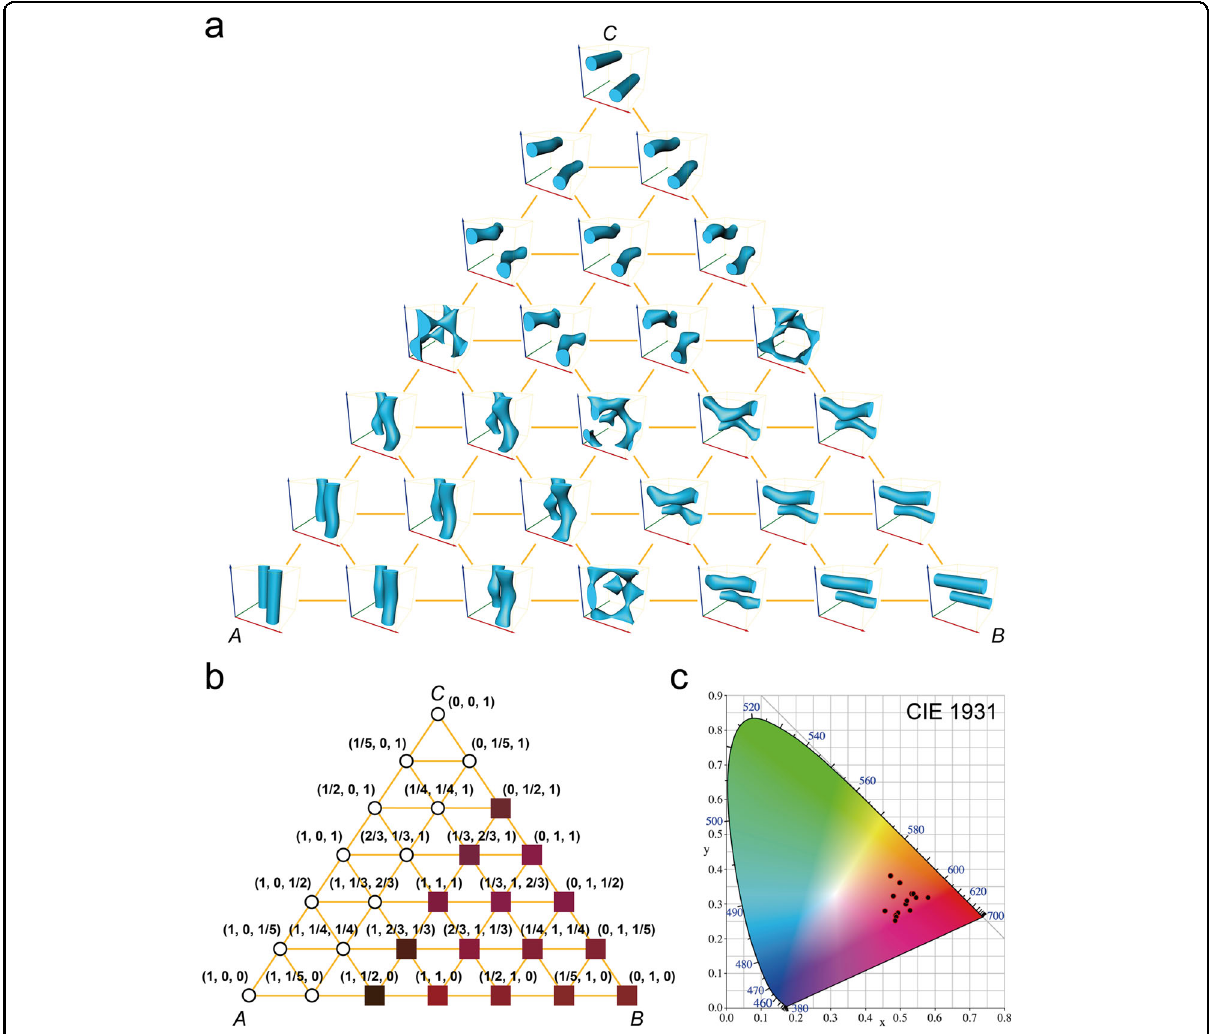
Fig. 3 Different morphologies and optical responses. a Tubular structural model under different forms. Red, green, and blue axes denote the x , y , and z directions, respectively. b Numerical parameter diagram matching of the structures in ( a ) and RGB color patterns calculated from the simulated optical results. c Color distribution from the simulated re fl ectance in the CIE 1931 chromaticity